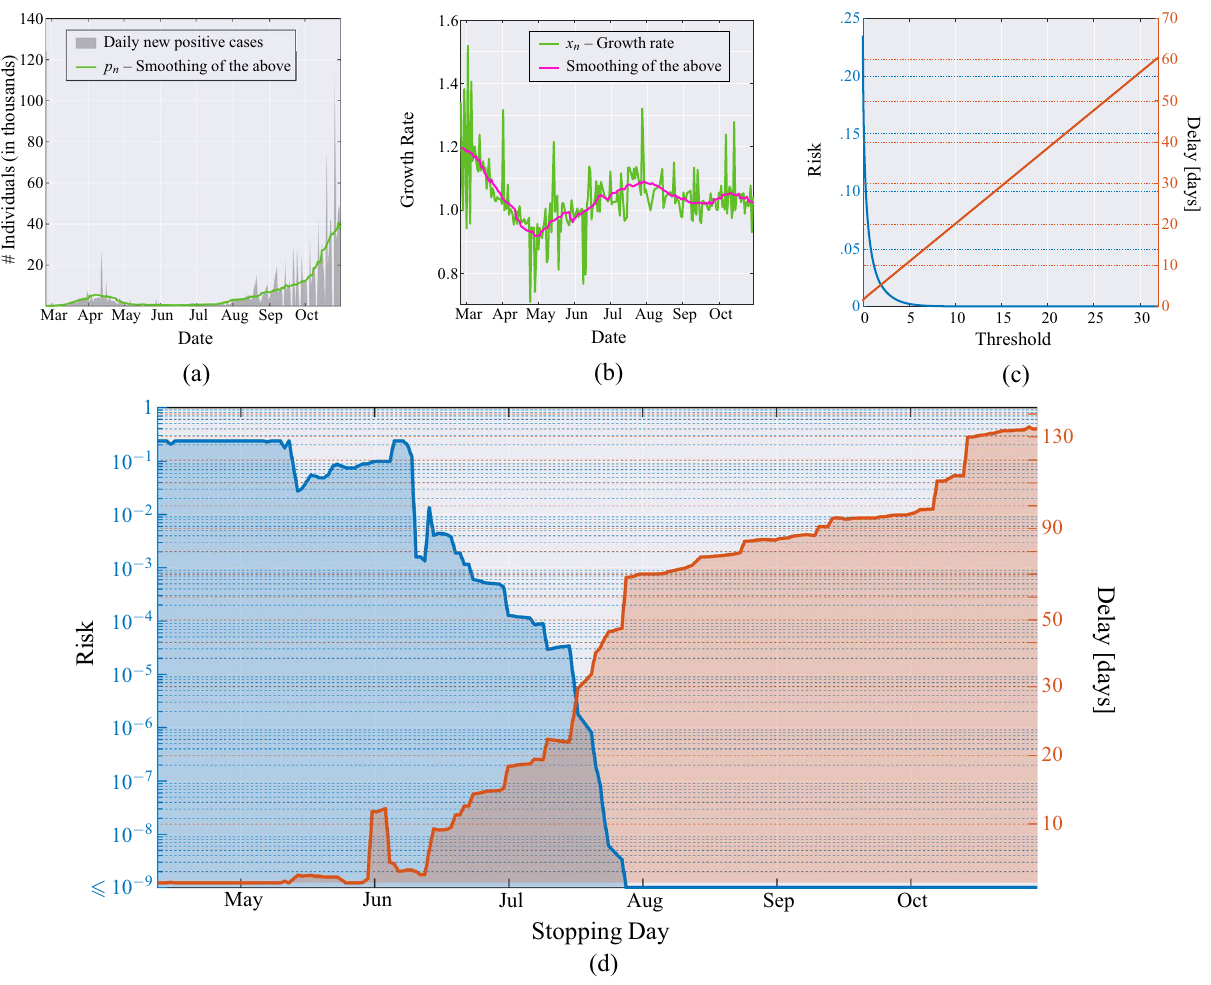
Figure 9. France. ( a ) Daily new positive individuals in France since February 25, 2020, and its moving average obtained with a window of 21 days (green line). ( b ) Growth rate of the epidemic computed from the averaged daily new positive cases (green line), and its time-varying mean obtained through a moving average that uses a window of 21 days (magenta line). ( c ) MAST performance, in terms of risk (left axis) versus threshold and mean delay (right axis) versus threshold, obtained from the French data of the COVID-19 pandemic. ( d ) Application of the MAST procedure on the COVID-19 pandemic data from France. On the left-side vertical axis, we select a desired risk, e.g., R = 10 − 4 . Then, the blue curve indicates the stopping day (about July 7, in the example) corresponding to the selected value of risk. Finally, the red curve referred to the right-side vertical axis shows the mean delay (cid:31) corresponding to the selected risk R (below 20 days). For clarity, note that the right-side scale for the delay is split into two linear ranges, for a better rendering of the small- (cid:31)